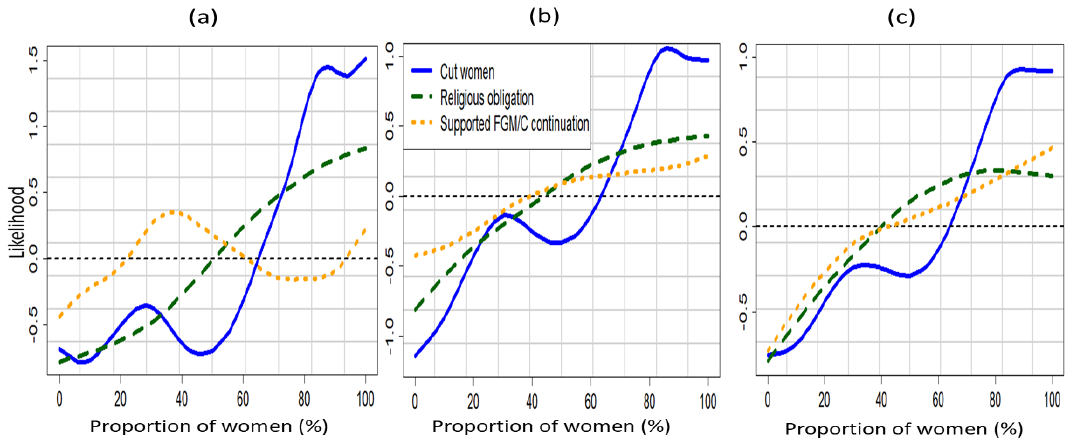
Figure 3. Non-linear effects of the proportions of women in a girl’s community who were cut (blue), who supported the continuation of FGM/C (orange), and who believed that FGM/C was a religious obligation for ( a ) Model A, ( b ) Model B and ( c ) Model C. Evidence from the 2014 KDHS.